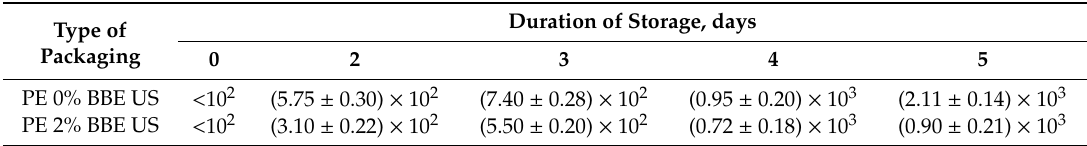
Table 7. Change in the content of the quantity of mesophilic aerobic and facultative anaerobic microorganisms, CFU / g, in parts of poultry carcasses during